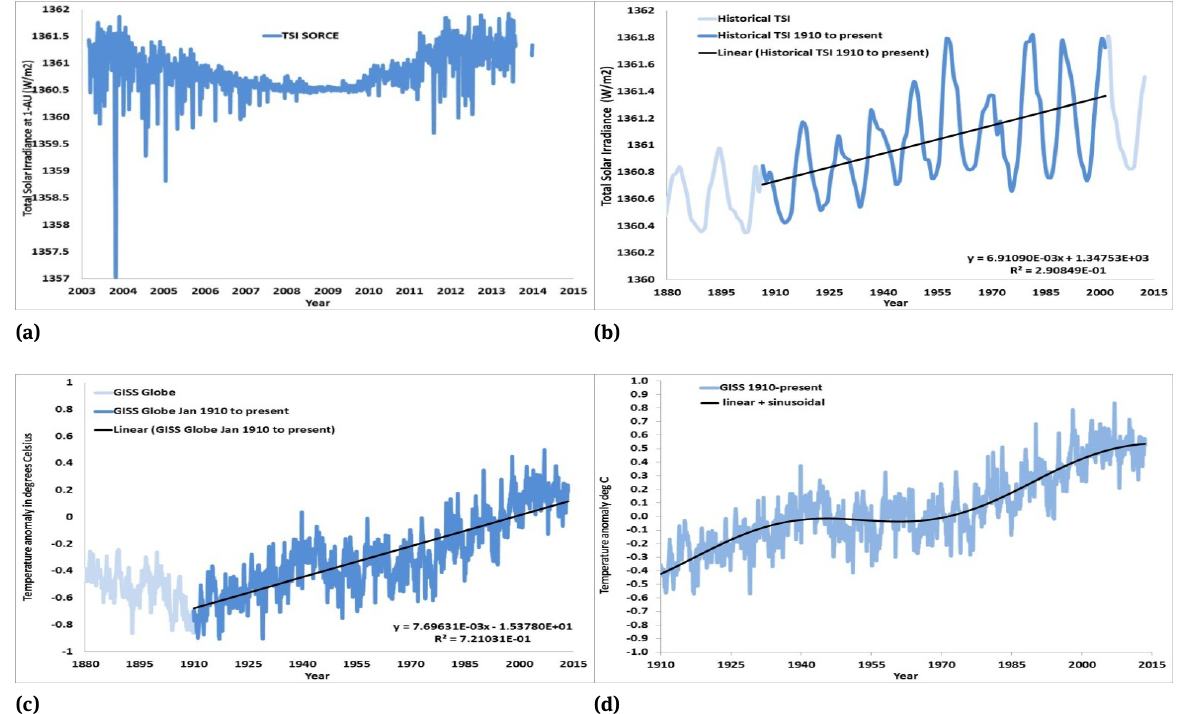
Fig. 1. a, b: Measured and reconstructed total solar irradiance (data from LASP [3]); c, d: reconstructed global land and sea air surface tem- peratures (data from NASA-GISS